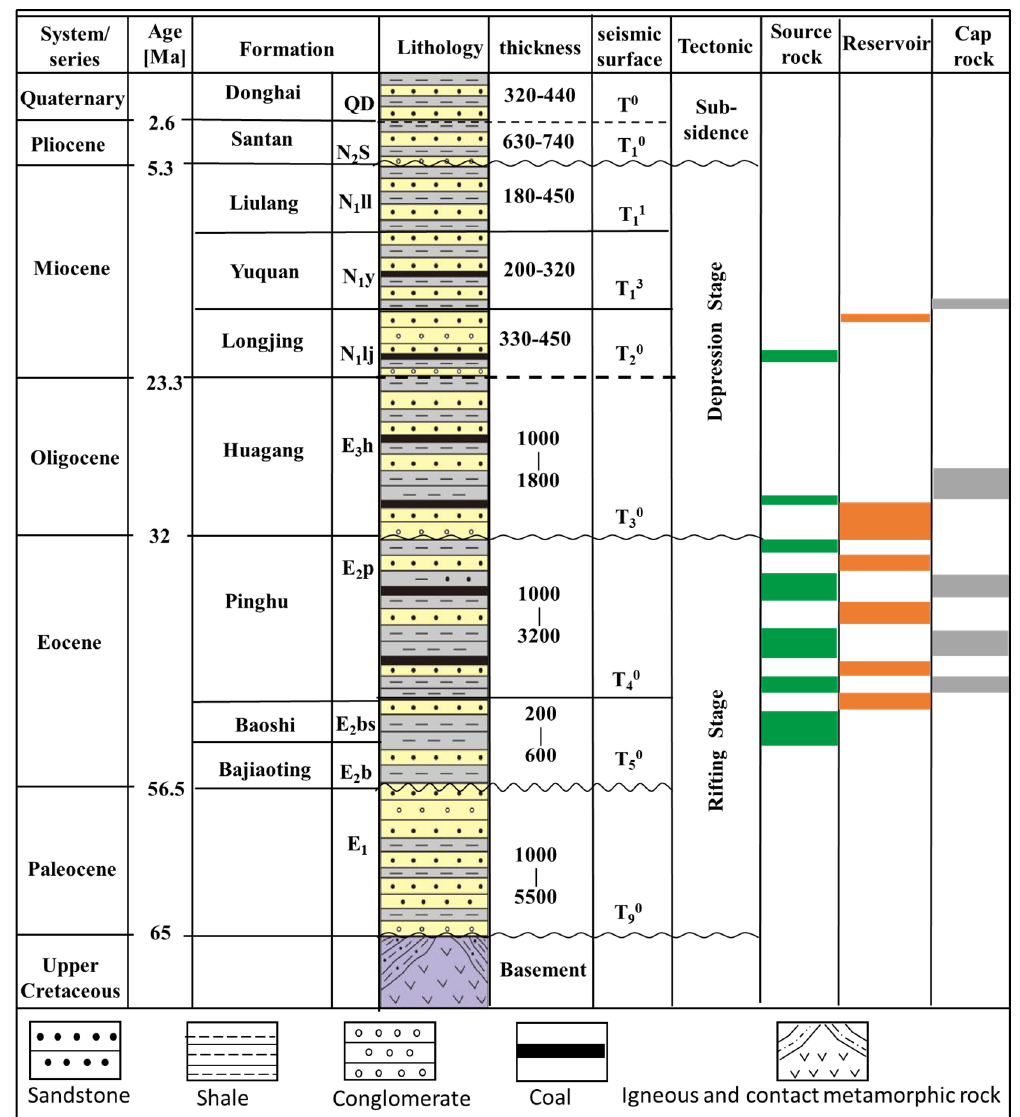
Figure 2. Stratigraphic column for the Xihu Sag.